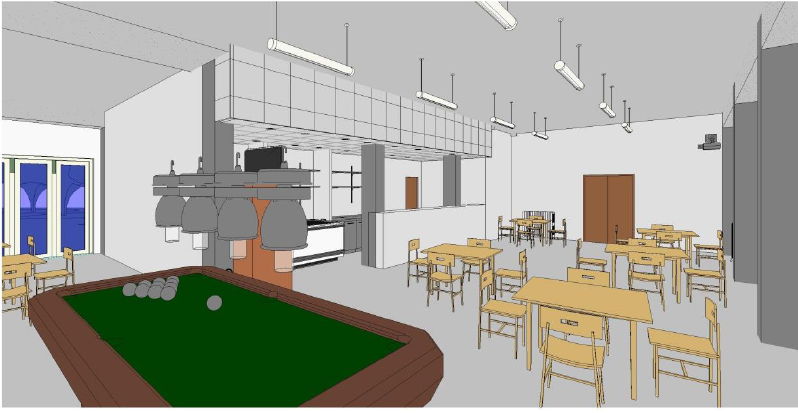
Figure 7. Real estate BIM modelling, internal view.